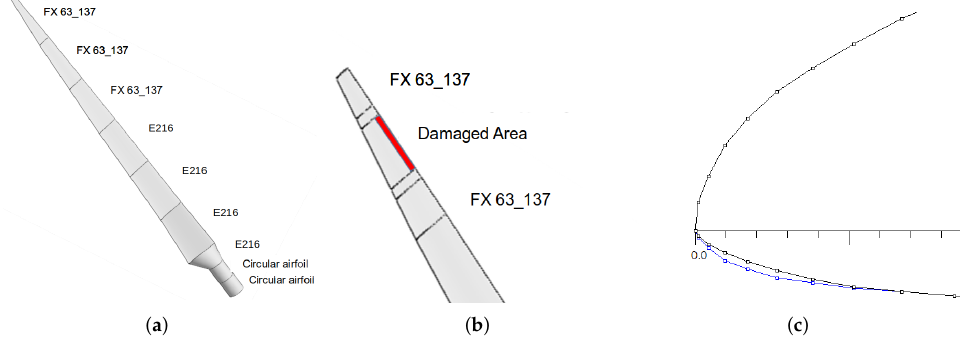
Figure 2. ( a ) Wind turbine blade design. ( b ) Area of erosion damage. ( c ) Blue line represents the clean Airfoil FX 63_137, while the dark line is the eroded blade considering case BI 1